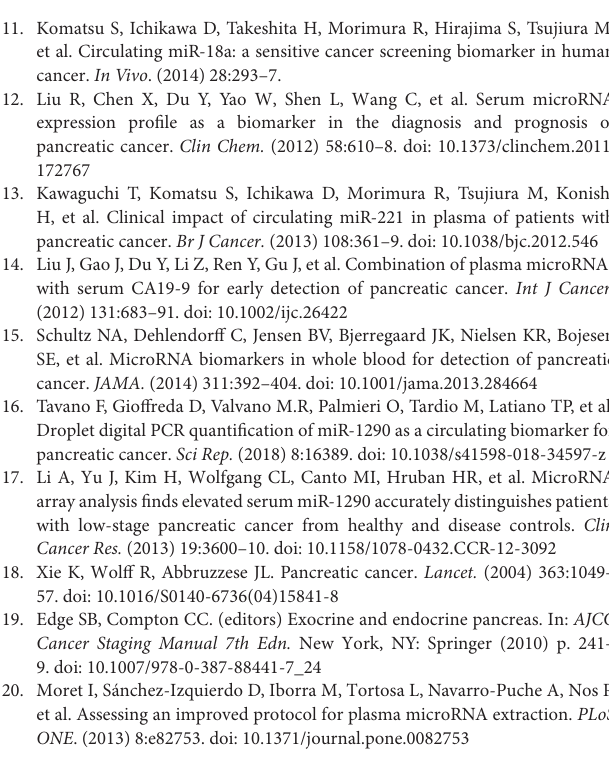
and disease free survival (DFS) of patients with pancreatic